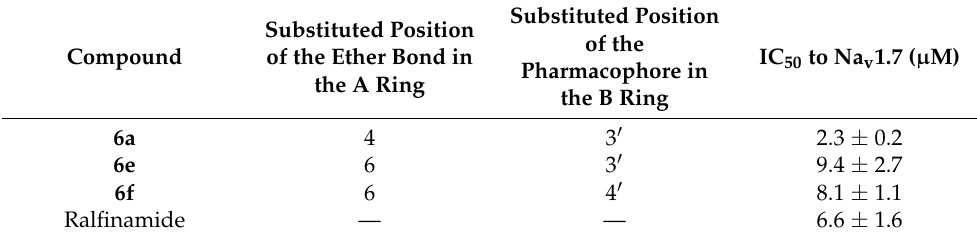
Table 4. In vitro inhibitory activity of novel compounds.